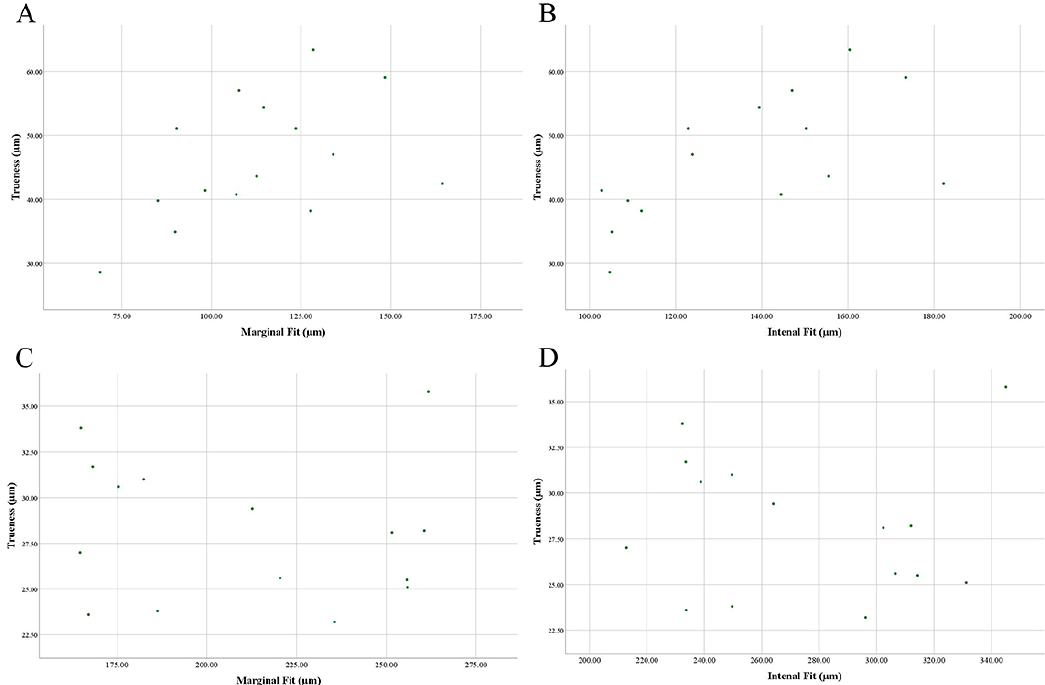
Figure 9. Relationships between the trueness of the milling unit and fitness. ( A ) In-lab group (trueness and marginal fit, p = 0.070). ( B ) In-lab group (trueness and internal fit, p = 0.013). ( C ) Chairside group (trueness and marginal fit, p = 0.855). ( D ) Chairside group (trueness and internal fit, p = 0.701).